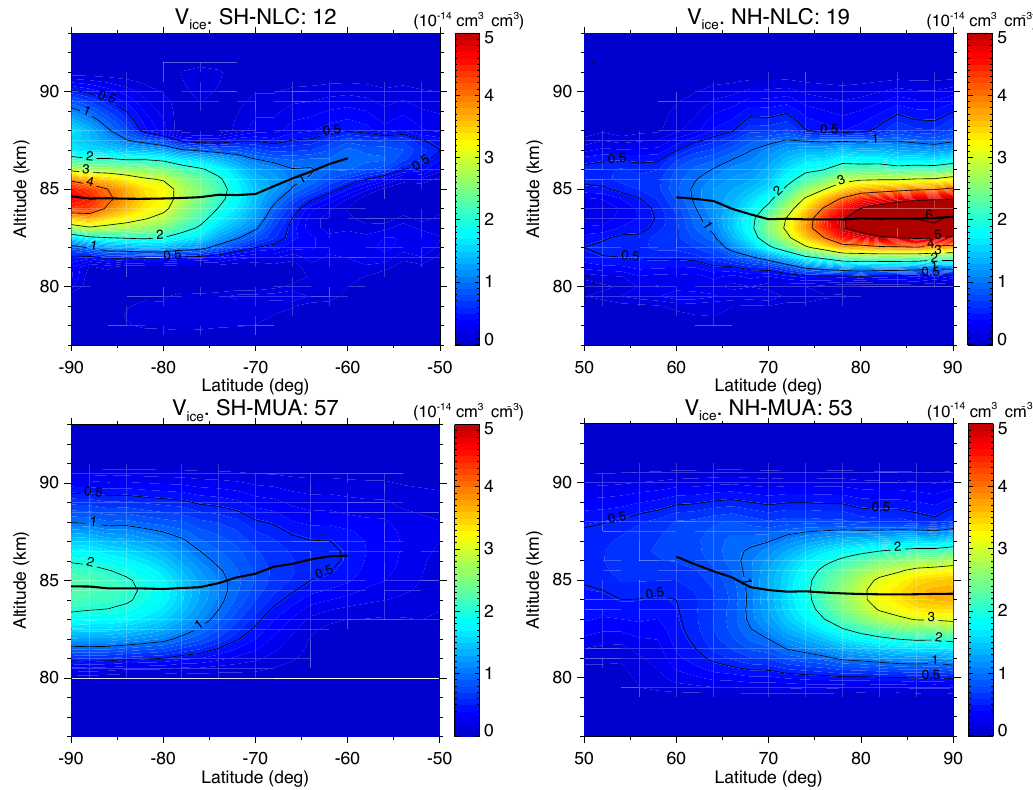
Figure 3. Zonal mean ice volume density for all measured days in the Southern (left panels) and Northern (right panels) hemispheres for the NLC (top panels) and the MUA (lower panels) MIPAS modes (see Table 2). The solid black line is an estimated mean altitude (weighted with the ice volume density to power of 4) of the PMC layer. The noise error of the volume density plotted here, estimated by the standard error of the mean, is about 0.08 and 0.04 × 10 − 14 cm 3 cm − 3 for the NLC and MUA measurements, respectively.